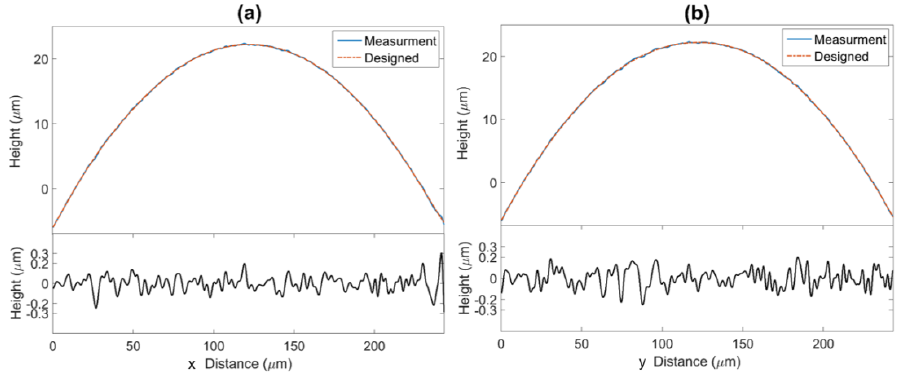
Figure 6. ( a ) Digital hologram recorded by transmission DHM and magnified central part. ( b ) Thickness information reproduced from ( a ).